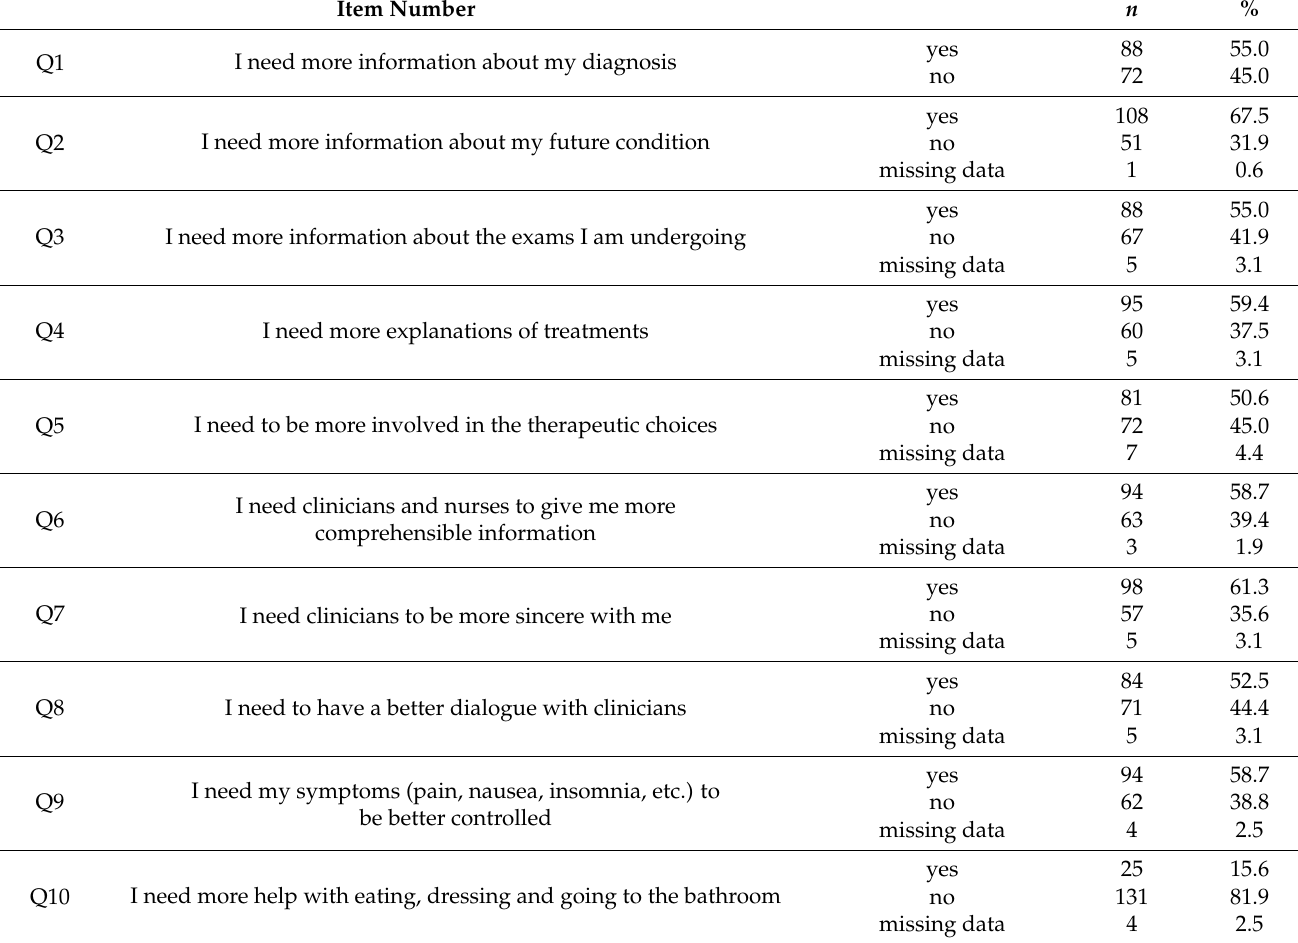
Table 3. The distribution of patients’